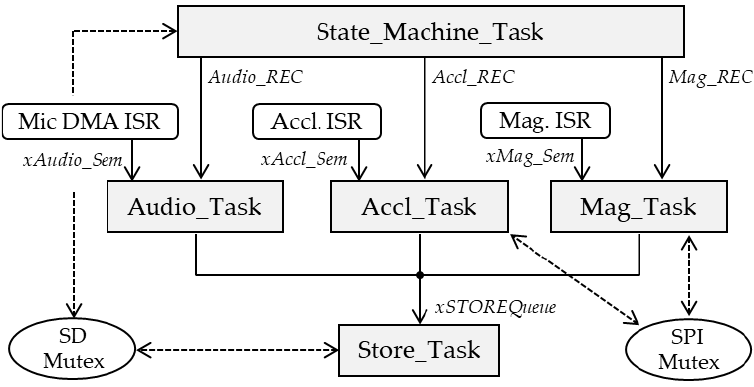
Figure 9. Firmware RTOS architecture.